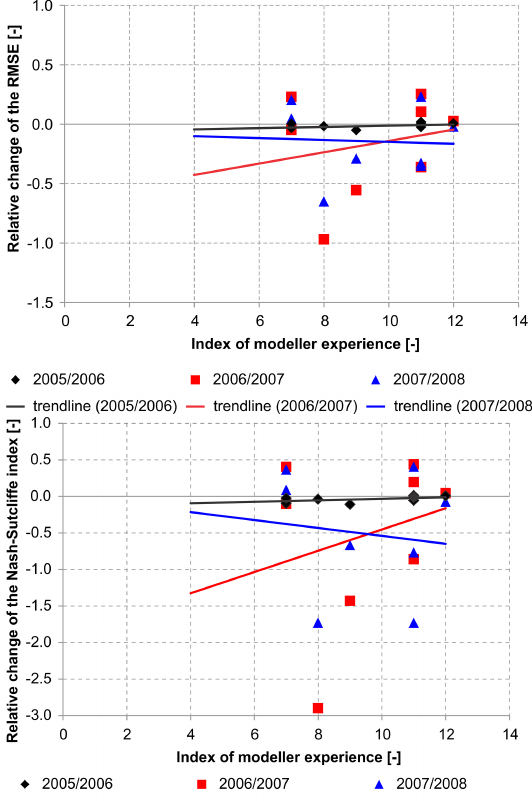
Figure 11. (a) Relationship between the indexed modeller expe- rience and the relative change of the RMSE (comparison of first and second prediction). (b) Relationship between the indexed mod- eller experience and the relative change of the Nash–Sutcliffe index (comparison of first and second